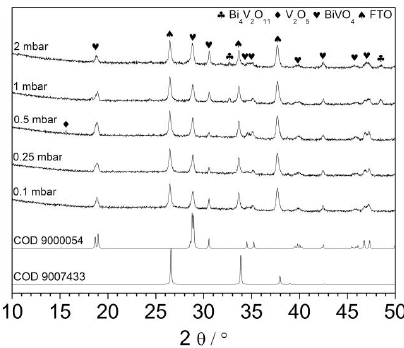
Figure 3. The comparison of XRD patterns recorded for FTO / BiVO 4 samples deposited at various oxygen pressures. B and V symbols denote Bi 4 V 2 O 11 and V 2 O 5 , respectively. COD 9000054—BiVO 4 and COD 9007433—SnO 2 .